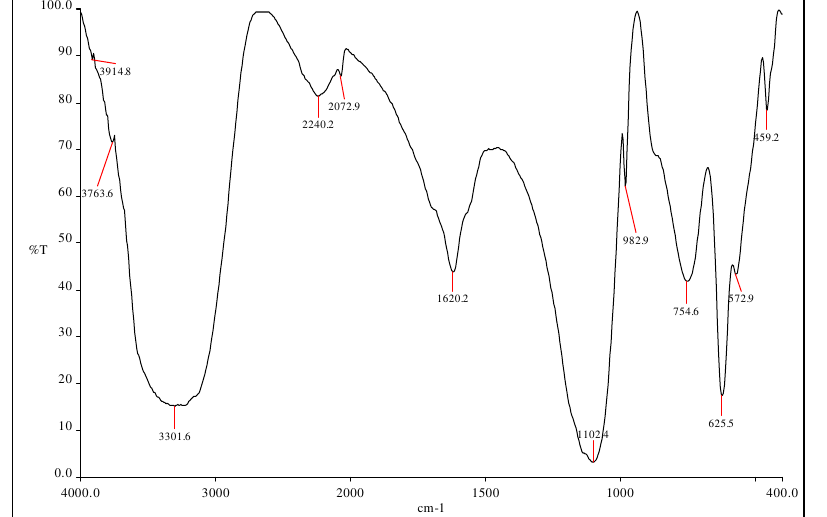
Figure 6. FTIR spectrum of ZSHH